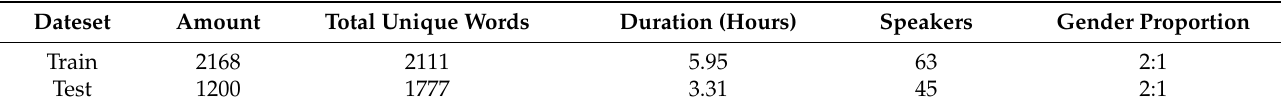
Table 3. Distribution of the data on the